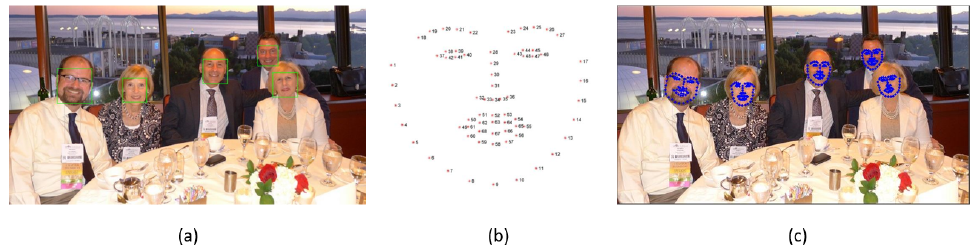
Figure 3. ( a ) Output of Get_Frontal_Face_Detected method of Dlib library. ( b ) Face location of each of shape_predictor_68_face_landmarks. ( c ) Output of pretrained model application